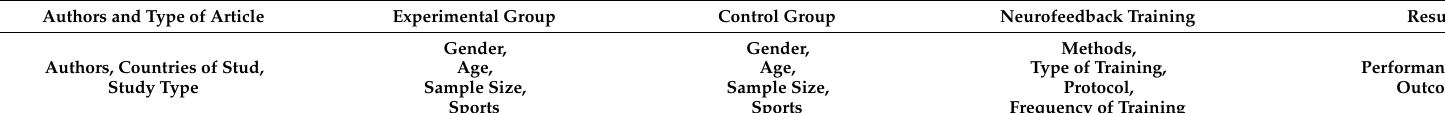
Table 3. Materials, methods and results of biofeedback training